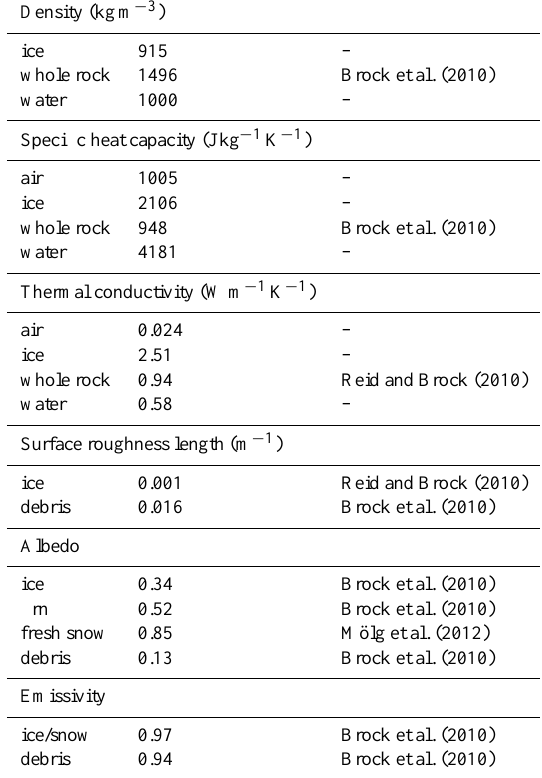
Table 1. Physical parameter values used in the CMB models. Density (kgm − 3